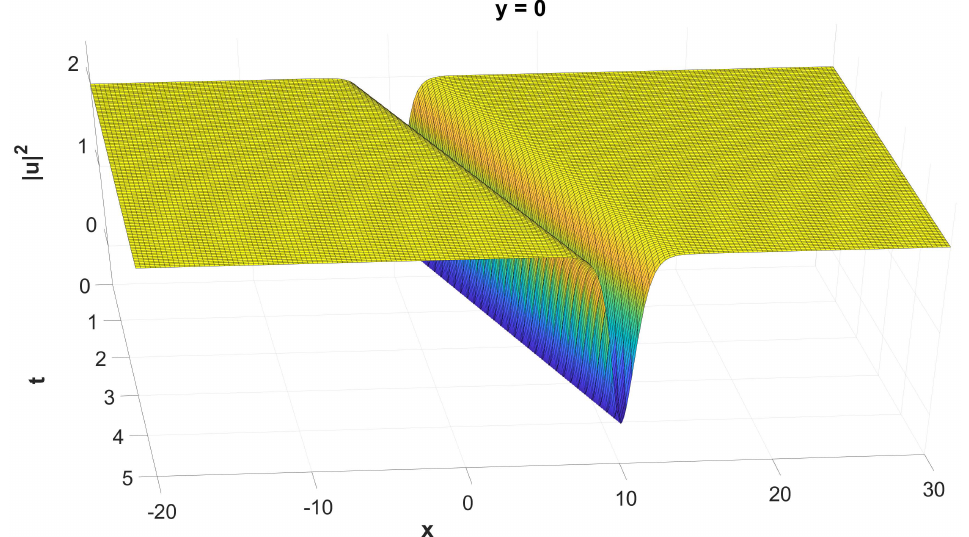
(cid:12) (cid:12) u ( x , y = 0, t )